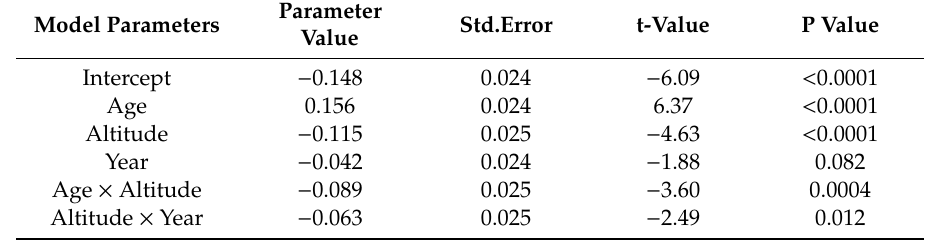
Table 4. Parameters estimated for the double interaction model including associated standard error, t statistic and p value.